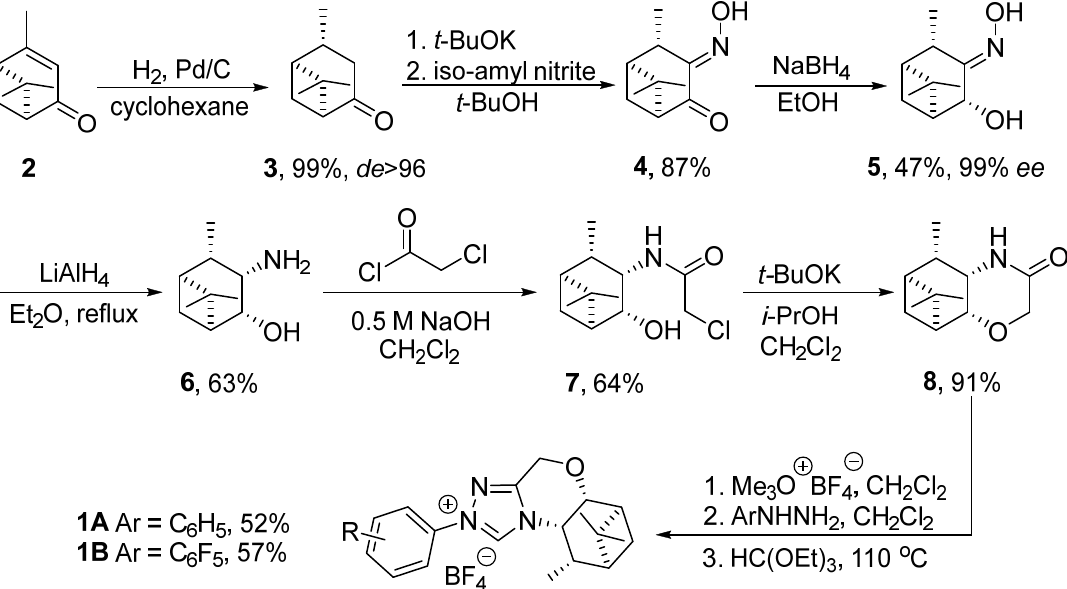
Table 1. NHC catalyst screening